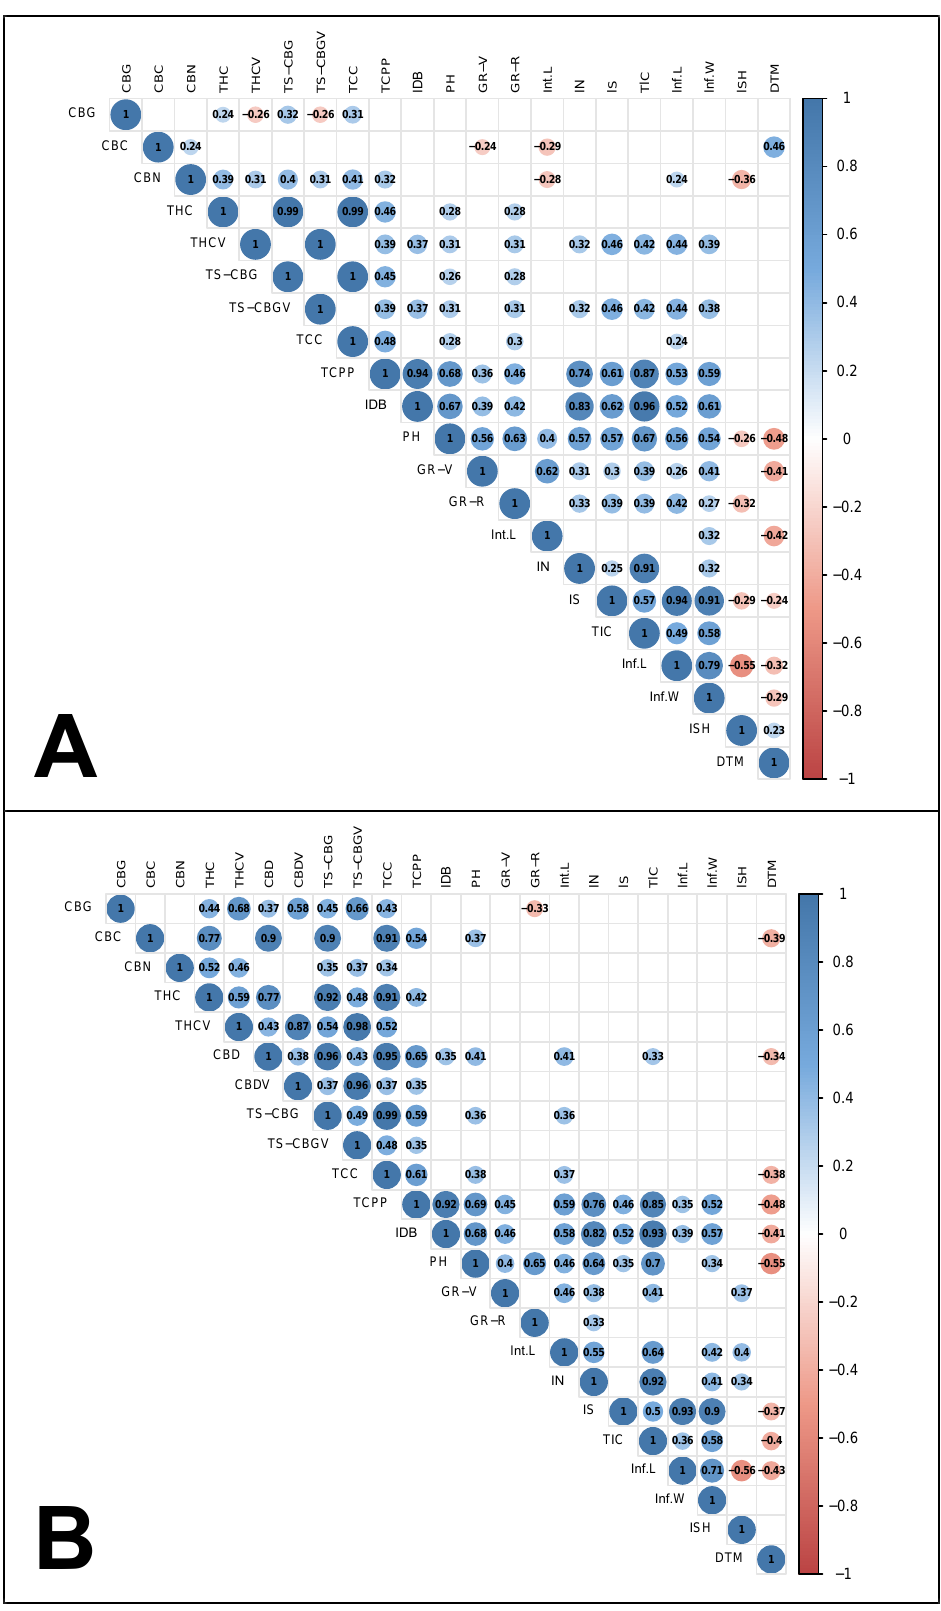
Figure 3. Correlation coefficient matrix for cannabinoid content, plant phenology, inflorescence morphology and key physiological attributes. ( A ) Correlations across high-THC genotypes ( n =